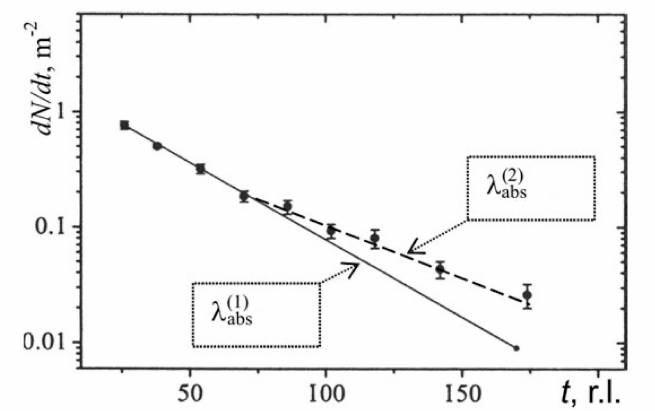
Figure 2. Distribution of hadron-initiated cascade origin points in deep uniform lead XREC 110-cm thick obtained by the Pamir experiment. E h ≥ 6.3